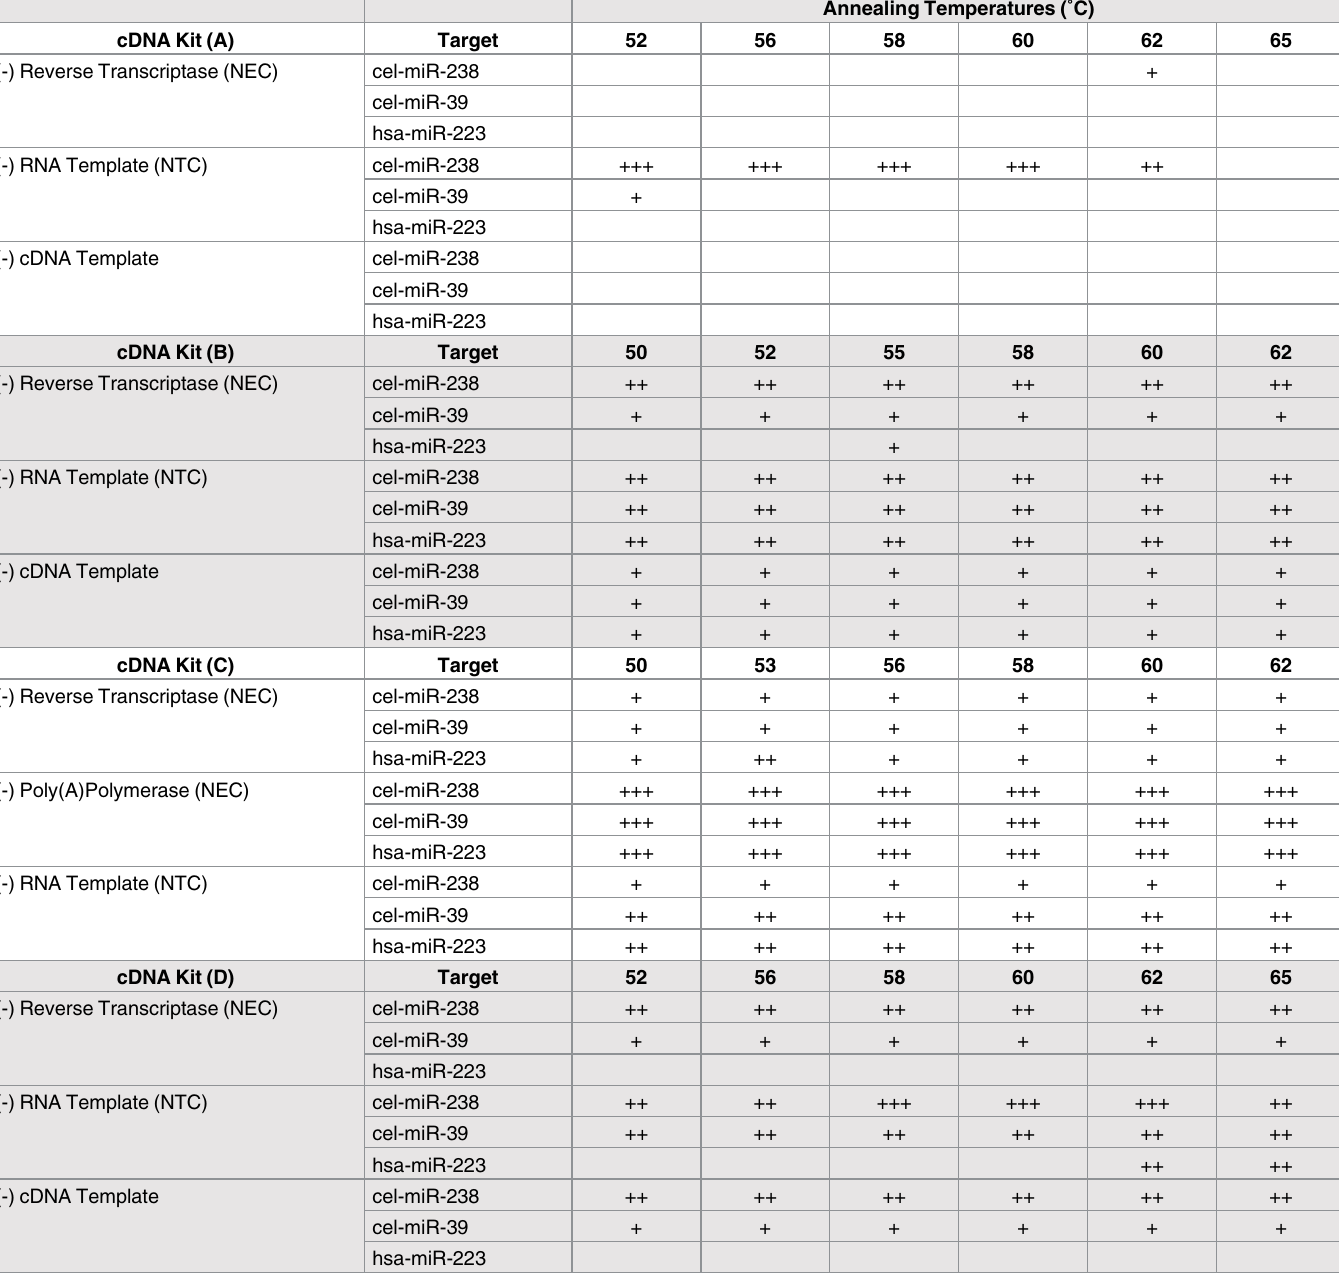
Table 5. Non-specific bands in control samples at different annealing